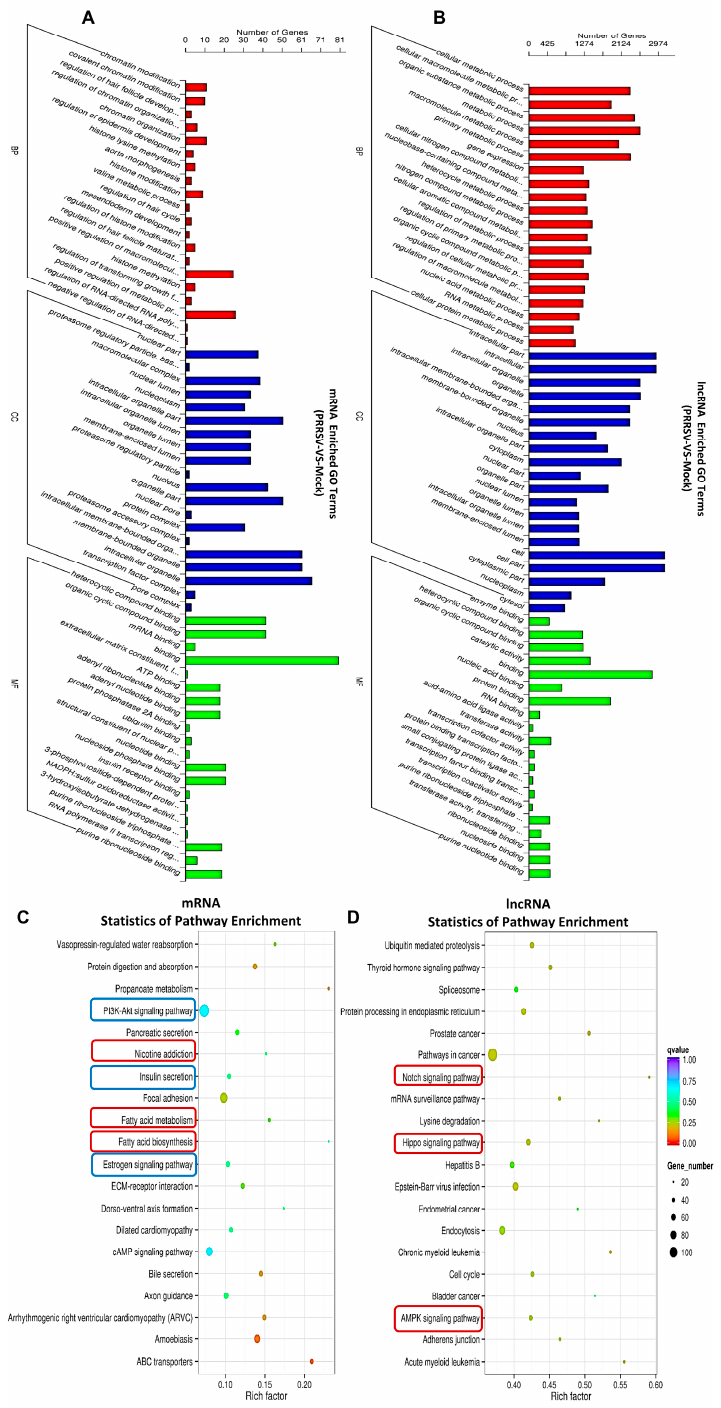
Figure 4. Pathway analysis for the dysregulated mRNAs and lncRNAs in the PTR2 cells infected with PRRSV. Significant enrichment of the GO terms of mRNAs ( A ) and lncRNAs ( B ). Analysis of the top 20 over-represented KEGG pathways of mRNAs ( C ) and lncRNAs ( D ). The enrichment factor was calculated as the number of enriched genes divided by that of all the background genes in each pathway. ( B , D ) show the enriched pathways of lncRNAs with effects in the trans-regulated